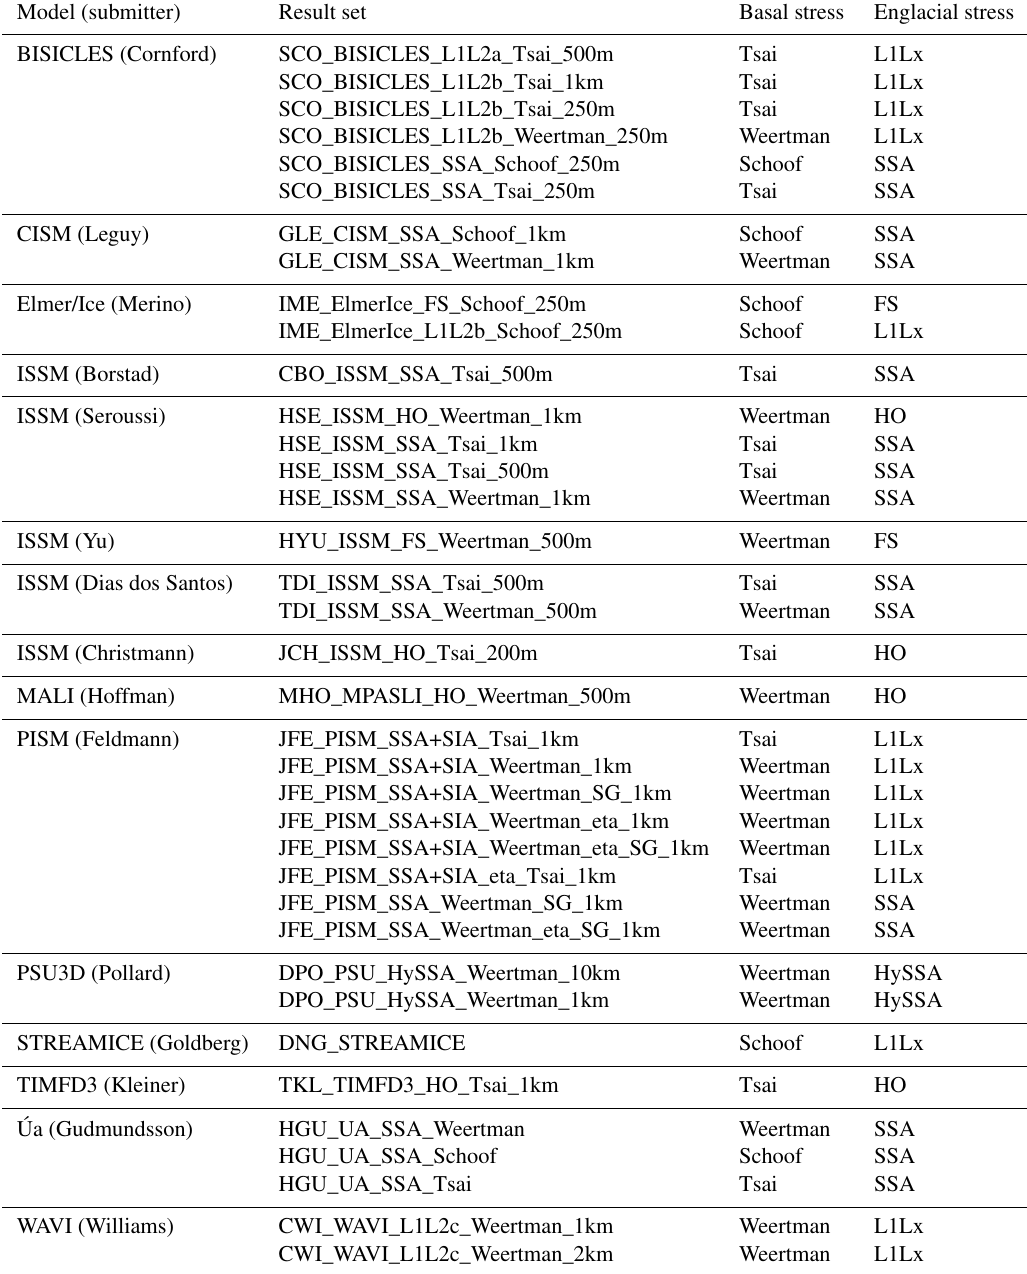
Table 2. Details of the participating models Model